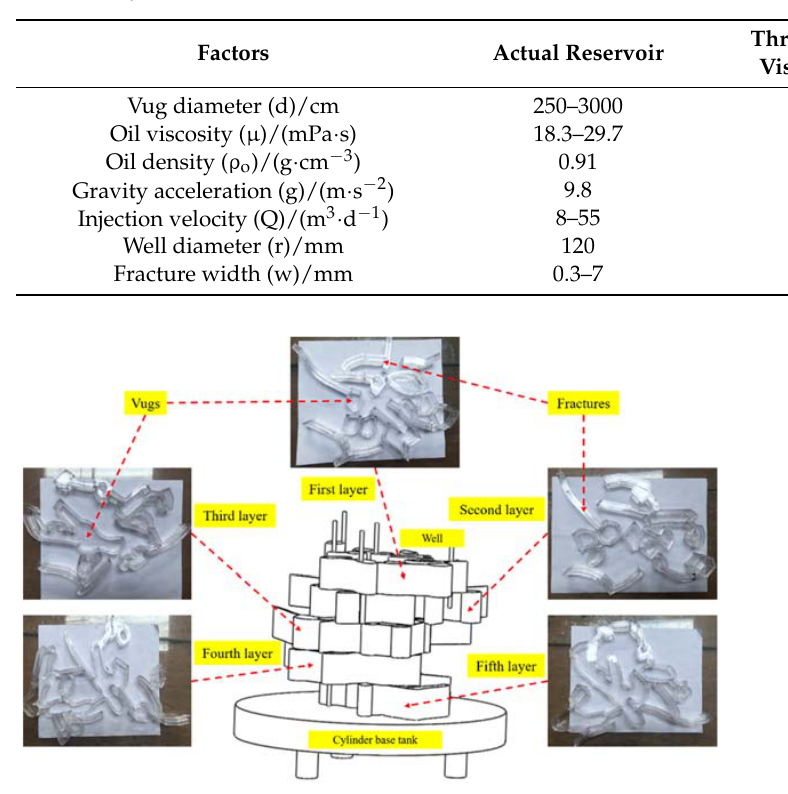
Figure 1. Fabrication of three-dimensional visualized fracture–vuggy physical model.